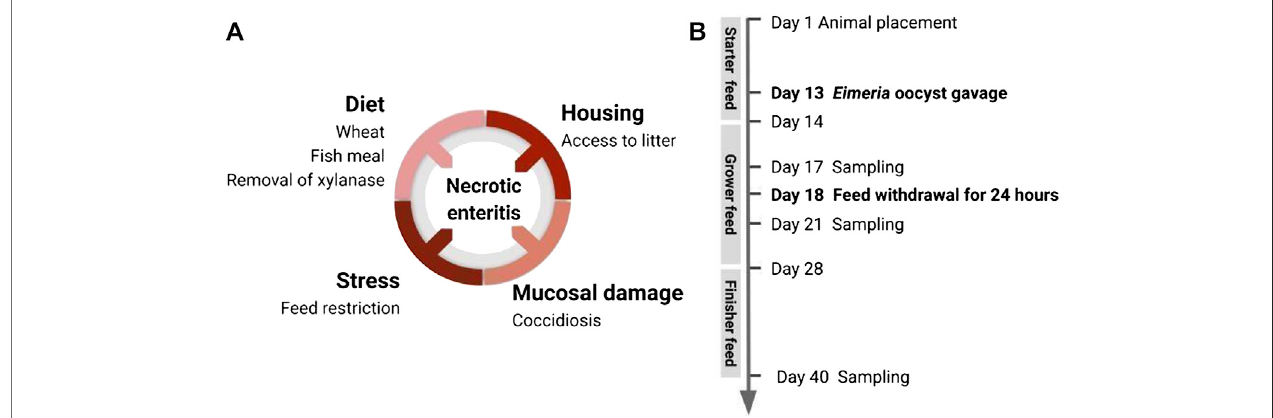
FIGURE2| InductionofsubclinicalNEinbroilerchickenbyapplicationofdiseasepredisposingfactors .(A) Topromotenaturaldevelopmentofthealready-existing virulent C perfringens in the gut, this disease model incorporated multiple predisposing factors: housing condition, diet components, coccidiosis-induced mucosal damage, and stressor leading to alteration of gut environment. (B) Timeline of animal handling and sampling schedule.